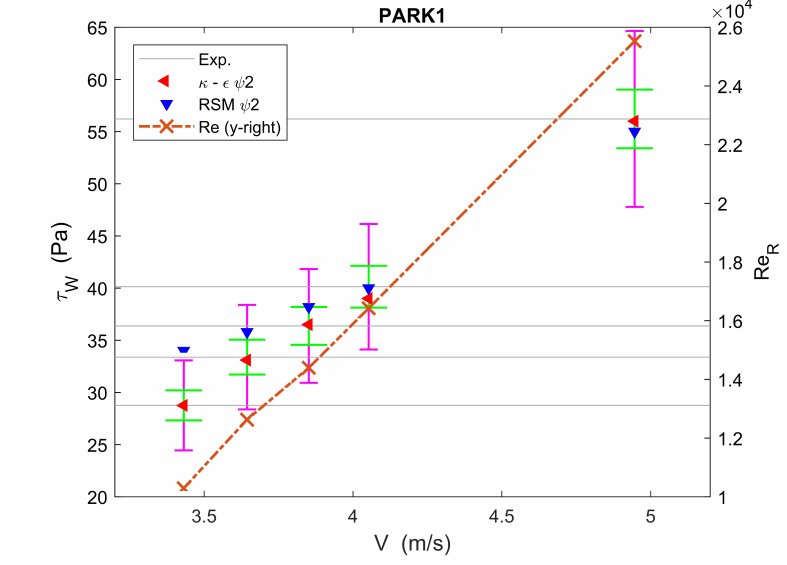
Figure 8. τ y = 9.3 Pa, m = 0.0894 Pas n , n = 0.7254 and D = 51